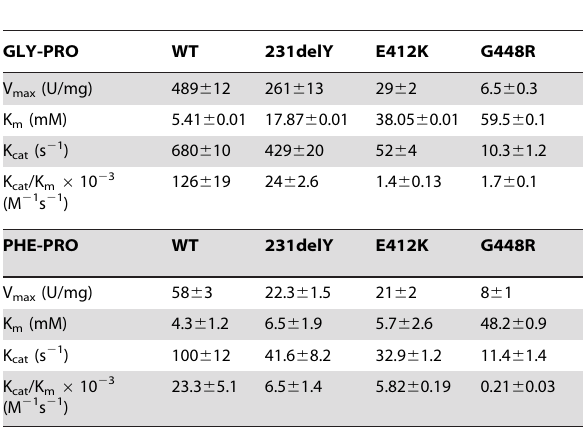
Table 1. Kinetic properties of hRecProl-WT and its pathological